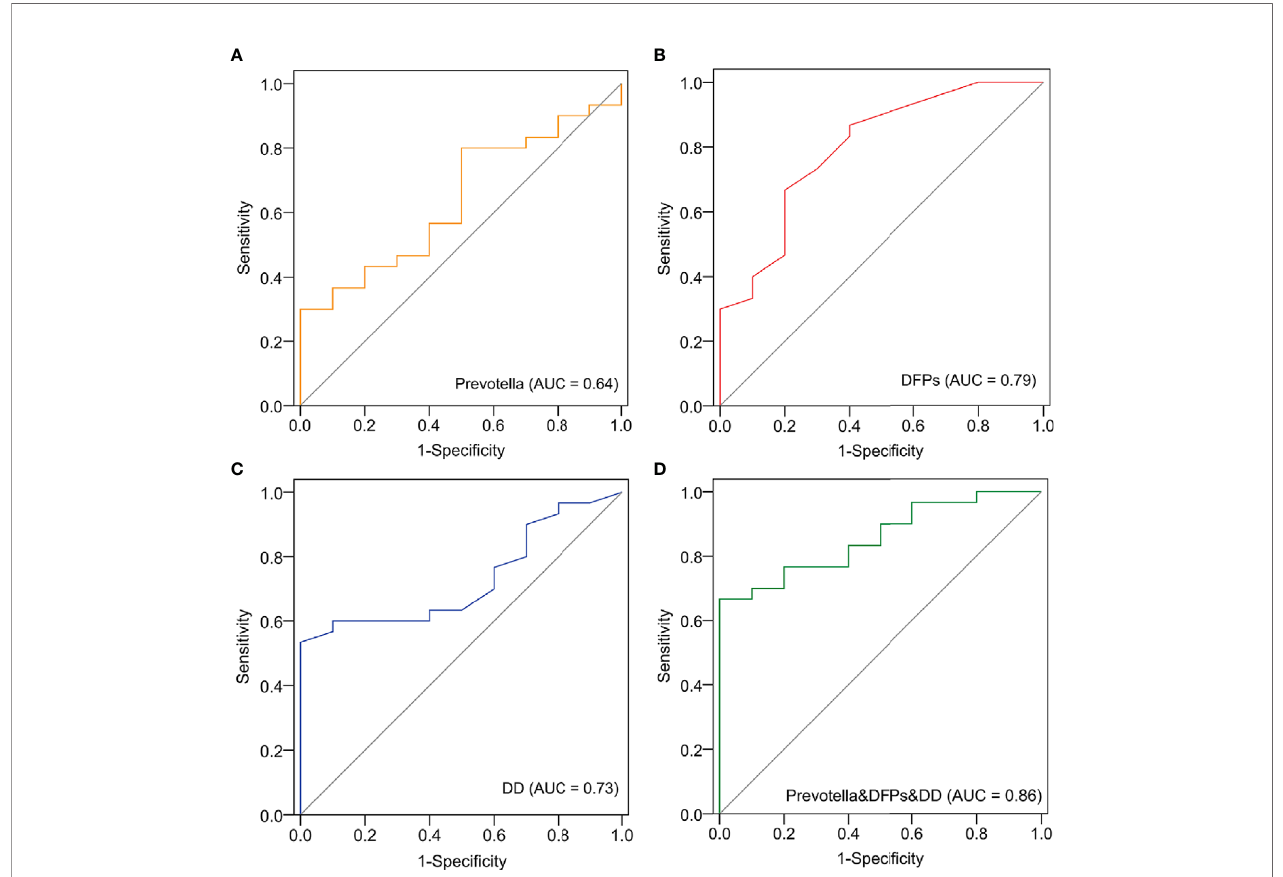
FIGURE 5 | Identi fi cation of Prevotella -based markers for the clinical prediction of EC. The receiver operating characteristic (ROC) curve and area under the curve (AUC) were generated to predict the onset of EC based on Prevotella (A) , fi brin degradation products (DFPs) (B) , D-dimer (DD) (C) , and joint modeling of the three factors (D)